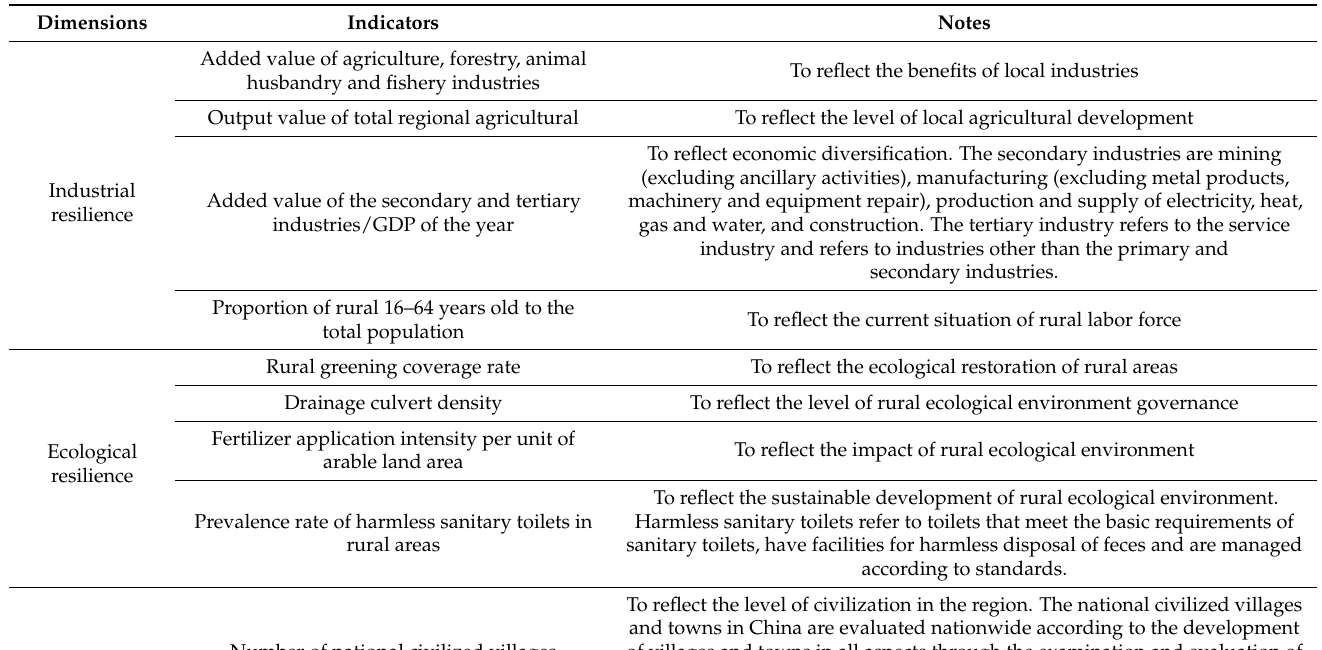
Table A1. Interpretation of indicators in the rural resilience evaluation index